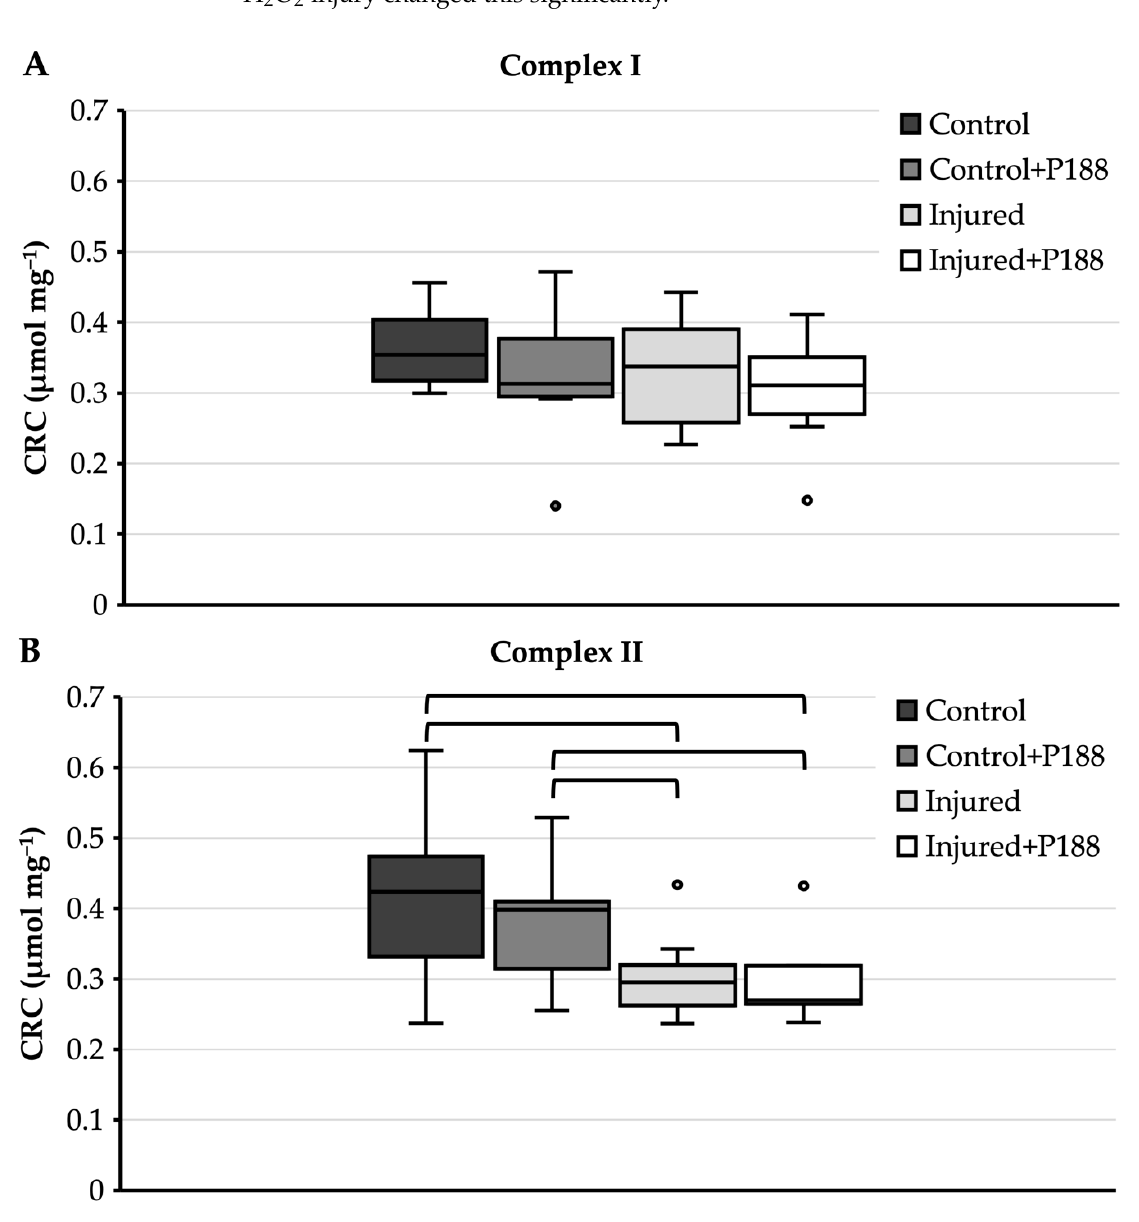
Figure 3. Calcium retention capacity (CRC) (µmol ⋅ mg − 1 ) in hydrogen peroxide (H 2 O 2 )-injured, isolated mitochondria for complex I ( A ) and II ( B ) substrates in control, control + Poloxamer (P)188, injured, and injured + P188 mitochondria. Boxplots show 25th, 50th, and 75th percentile; whiskers represent minimum and maximum. Statistical significance ( p < 0.05) denoted by brackets; complex I: n = 4, complex II: n = 5.